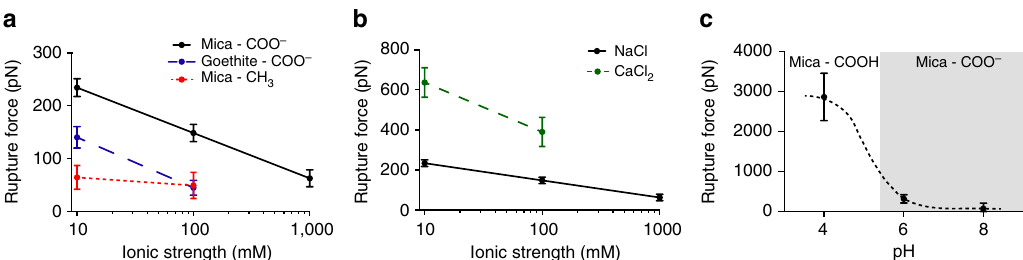
Fig. 4 Values for the strength of binding as a function of local environmental conditions. Organic – mineral interactions are affected by ionic strength, ion composition, and pH. a Ionic strength was varied using NaCl electrolyte at pH = 6. Interactions between COO − and either mica or goethite were investigated. The CH 3 functional group was used as a control interaction on mica. b The effects of monovalent (NaCl) and divalent (CaCl 2 ) cations were compared using the carboxylic acid functional group and mica at pH 6 at varying ionic strengths. c The effect of binding between carboxylic acid and mica was probed as a function of pH in 10 mM NaCl solution. For each condition, experiments were performed with the same AFM tip for reproducibility. Rupture forces were measured at loading rates of 3.5 × 10 − 9 N/s. Values are represented as mean ± 1